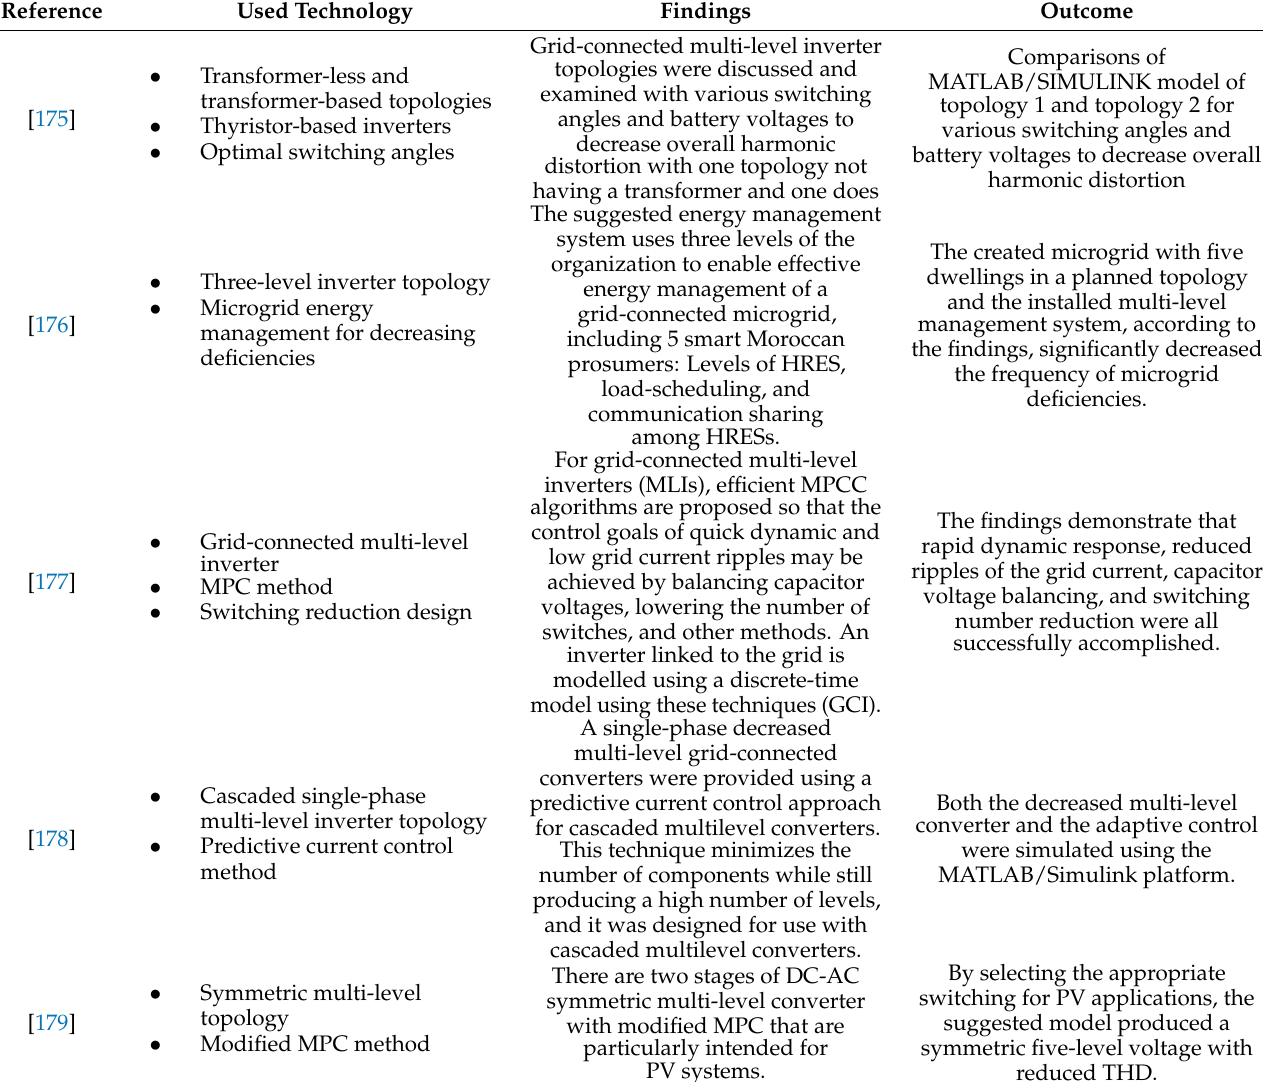
Table 6. Comparative analysis of innovative